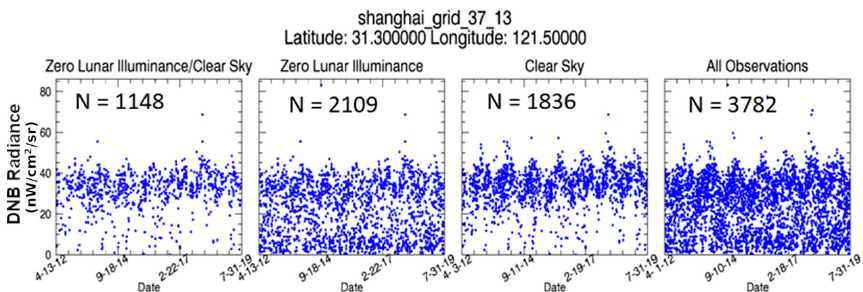
Figure 4. The effects of filtering to remove cloudy and moonlit data from a VIIRS DNB profile from Shanghai, China.